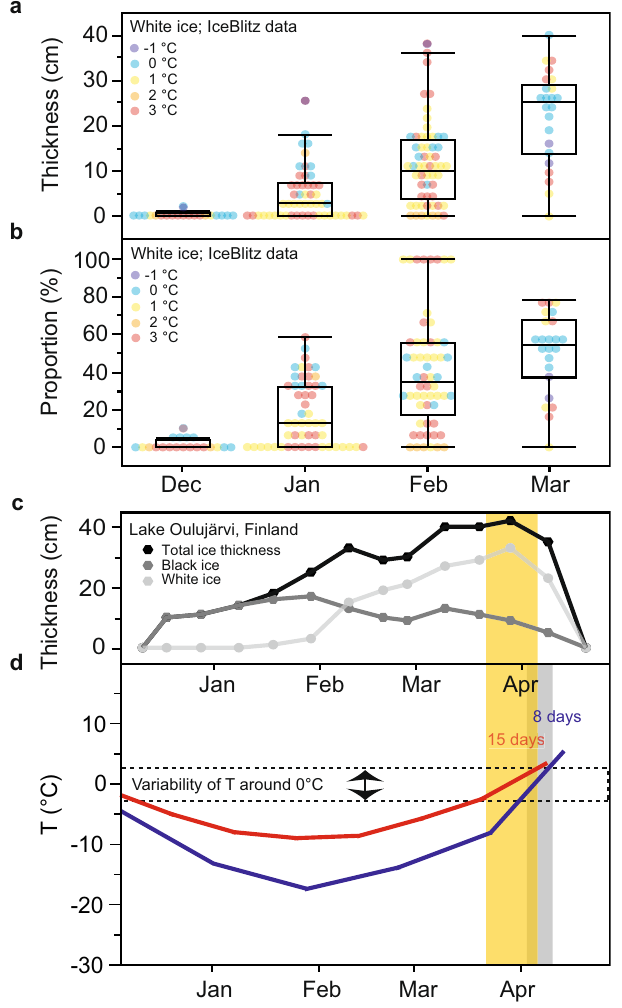
Fig. 2 | Seasonal accumulation of white ice in lakes. a , b Boxplots showing the seasonaldevelopmentofthethicknessofwhiteiceandthepercentageofwhiteice observed in 31 Northern Hemisphere lakes during the IceBlitz sampling campaign in 2020/2021. Boxplots depict the minimum, fi rst quartile, median, third quartile, and maximum. April values are not shown because too few measurements were available from that month. Colors represent the lake site-speci fi c mean air tem- perature anomaly during December through March in 2020/2021 relative to the base period 1951 – 1980. Except for the lakes located on the Kola Peninsula (Northwest Europe), all lakes experienced warmer than normal winter air tem- peratures during the IceBlitz campaign. Eight lakes even had 3°C warmer air temperatures compared to 1951 – 1980. c Seasonal development of total ice thick- ness and the thickness of black and white ice in Lake Oulujärvi, Finland during 2020/2021. The orange shaded area marks the time period when air temperatures varied around the freezing point, which is relevant for the formation of white ice. d Simpli fi ed, typical winter air temperature (T) curves representing a cold (blue line) and a warm (red line) winter (data taken from Weyhenmeyer et al. 26 ). The number of days when air temperatures vary around the freezing point increases when the seasonal cycle of winter air temperatures falling below 0°C fl attens during a warm year 26 . In our conceptual fi gure, the number of days when air tem- peratures vary around the freezing point corresponds to ~15 days during a warm winter (marked in orange) compared to ~8 days during a cold winter (marked in